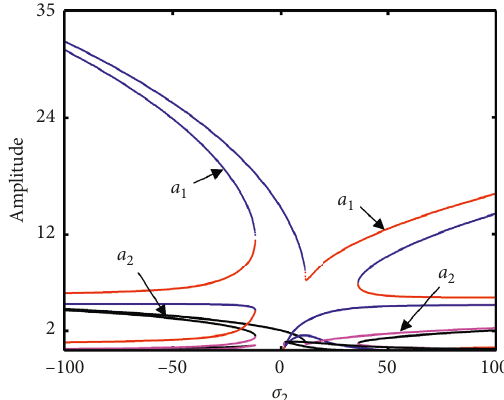
Figure 6: Frequency-response curves obtained when g g � − 0 . 13, and σ 9